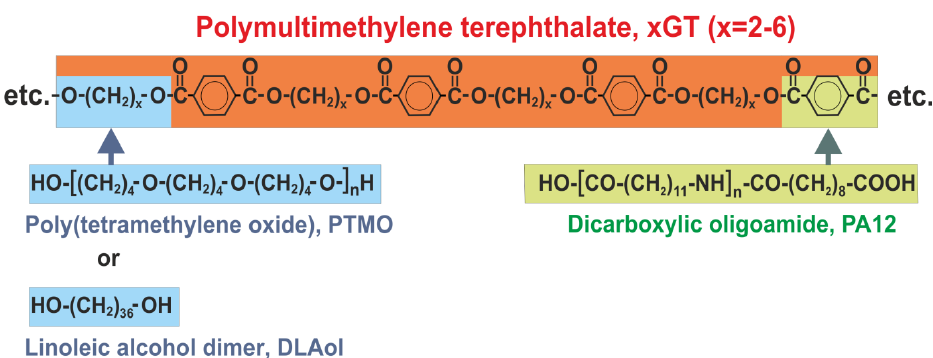
Figure 1. Polymultimethylene terephthalate modification.